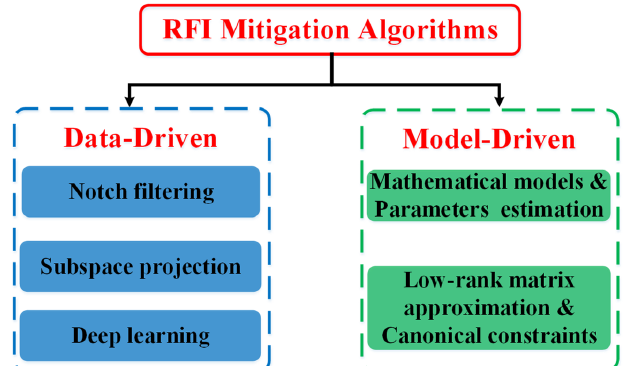
Figure 1. Classification diagram of RFI mitigation algorithms.